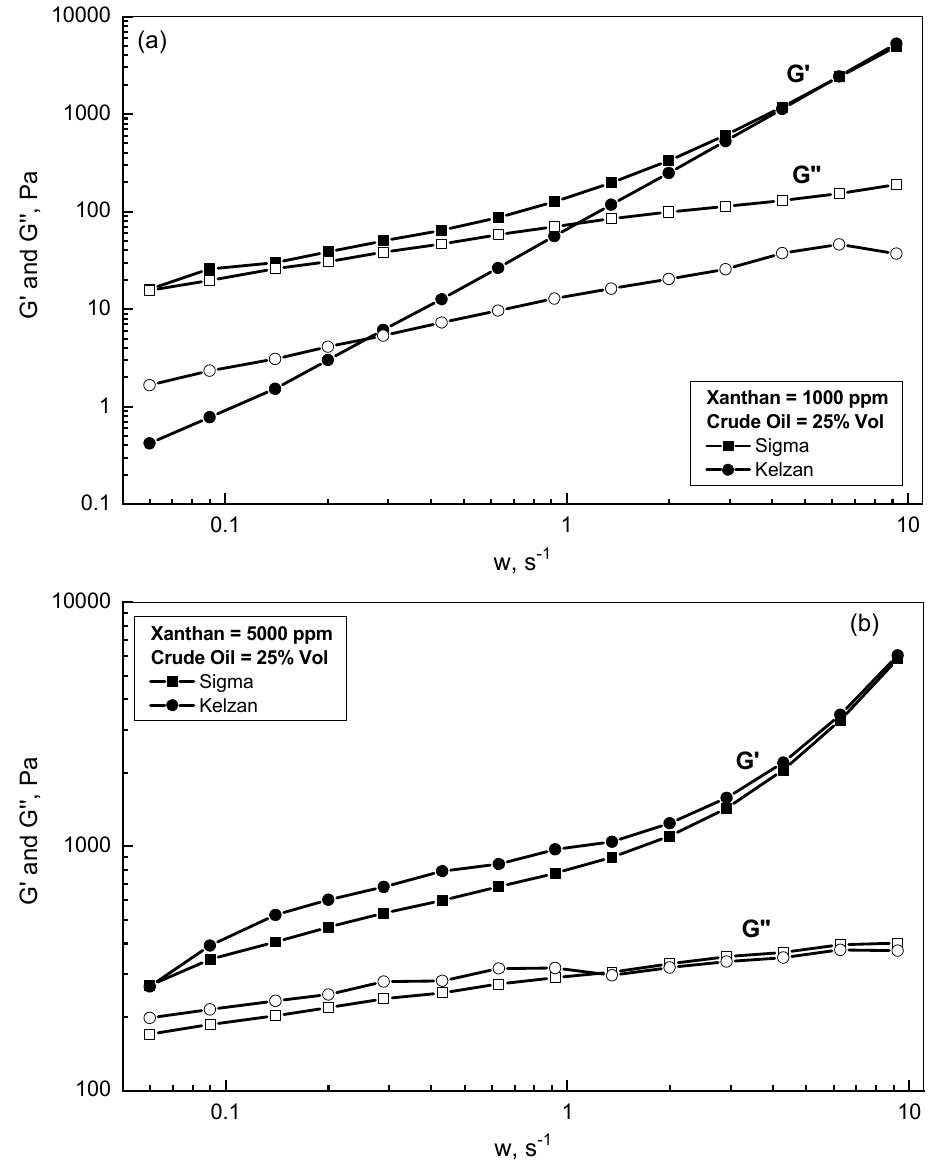
Figure 8. G' and G'' behaviors of different Sigma and Kelzan emulsions. Figure 8. G (cid:48) and G (cid:48)(cid:48) behaviors of different Sigma and Kelzan emulsions. ( a ) Xanthan = 1000 ppm;